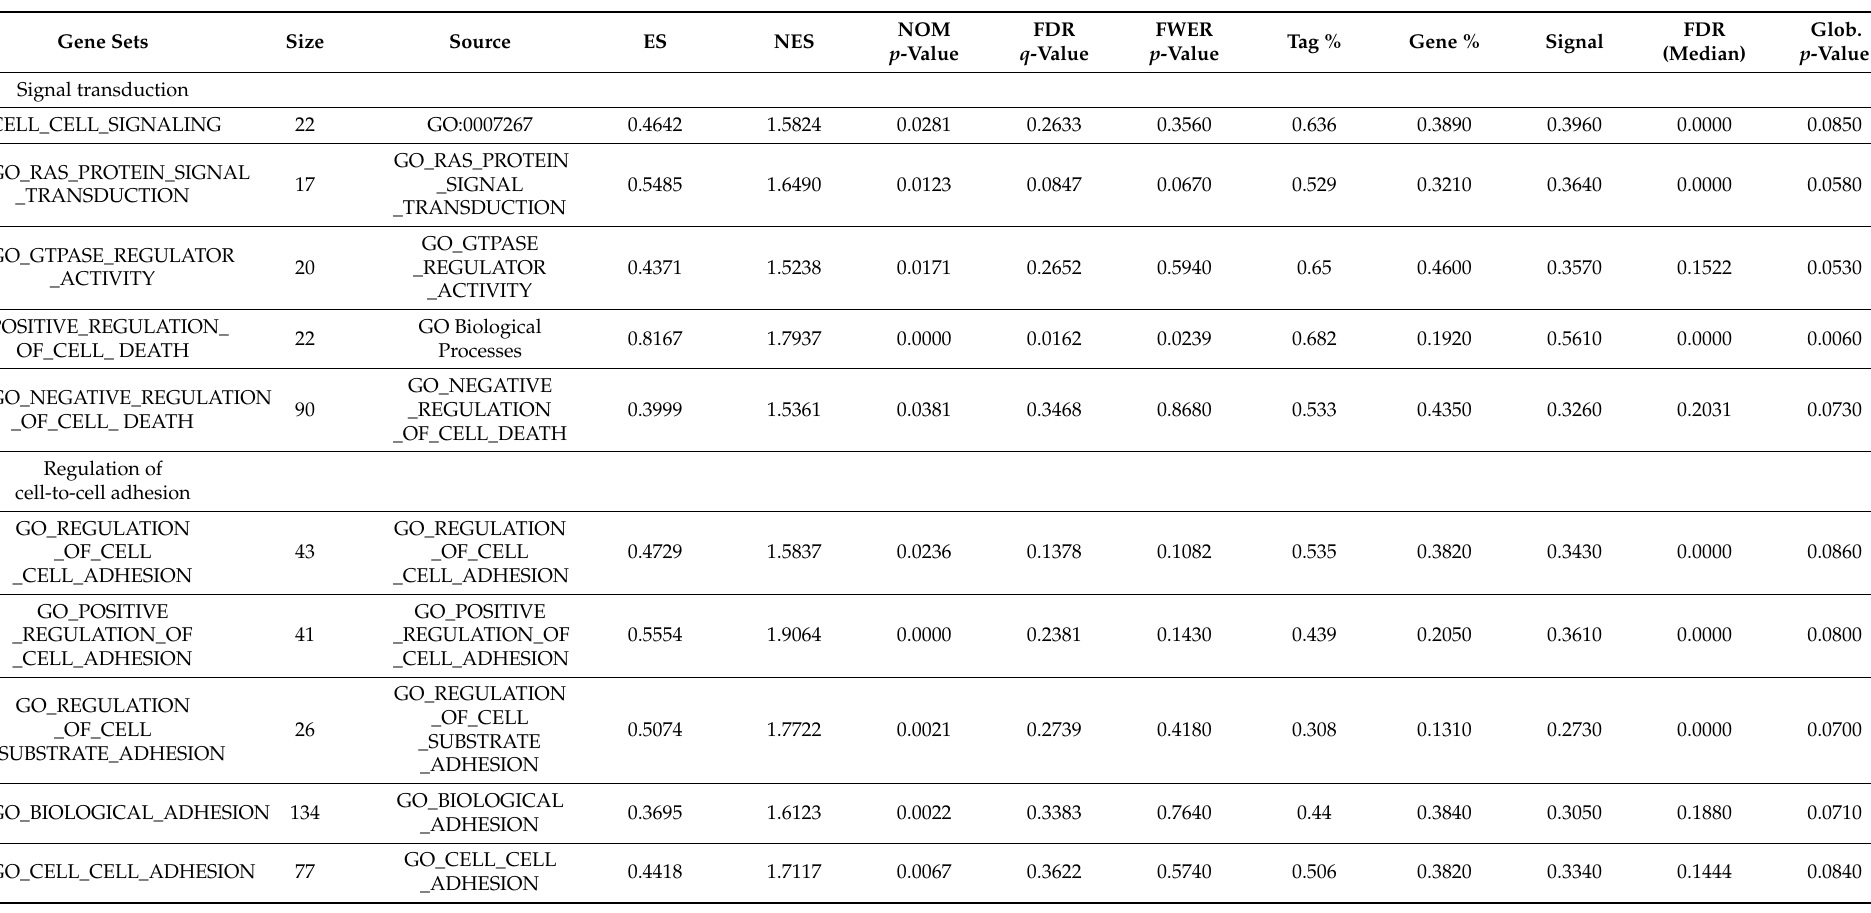
Table 5. Gene sets differentially overrepresented in severe asthmatics vs. healthy